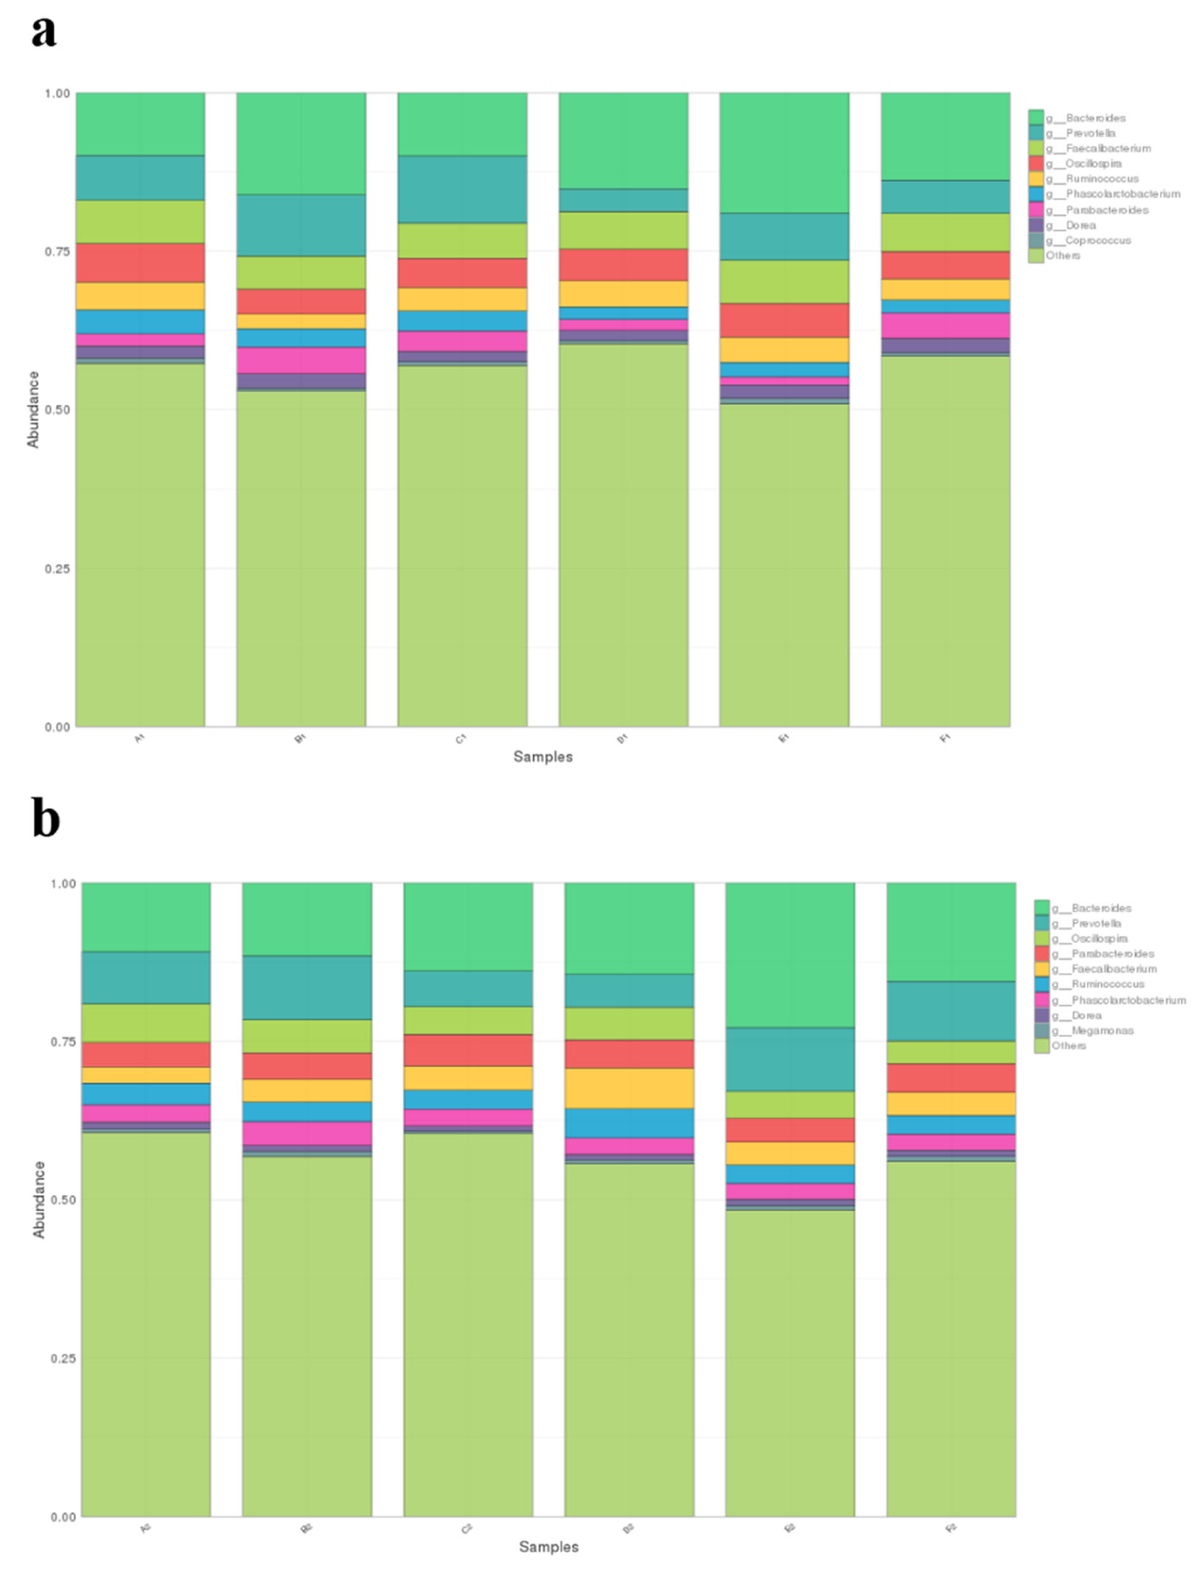
Figure 3. ( a , b ) Distribution of the taxonomic stack of the microflora in the cecum of broiler chickens at the genus level. The colored bar graph shows the distribution of the level of the bacterial genus in different treatment groups.